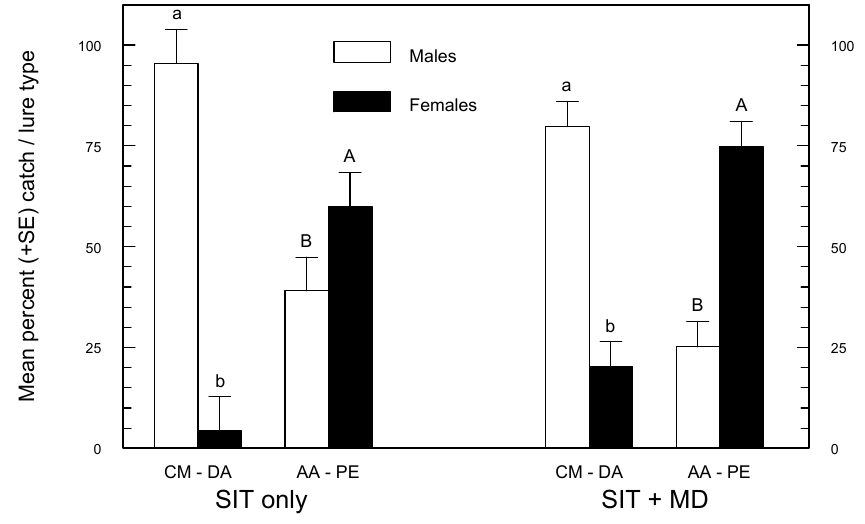
Figure 2. Mean (±SE) percentage of male and female sterile codling moths caught in white delta traps baited with either a single 8 mL propylene bottle containing two small cotton balls with a 3 mm diameter hole in its lid and loaded with 5 mL of an acetic acid plus PE mixture (240:1 µL v:v ) (AA-PE), or a grey rubber septum loaded with 3 mg of codlemone and 3 mg of ethyl-( E , Z )-2,4-decadienoate (CM-DA) in an orchard receiving sterile moths only (SIT) and one receiving sterile moths combined with an Isomate-CM/LR-TT pheromone mating-disruption treatment (SIT + MD). Paired bars within an orchard and lure treatment having different letter superscripts are significantly different by paired t -tests ( p < 0.05).